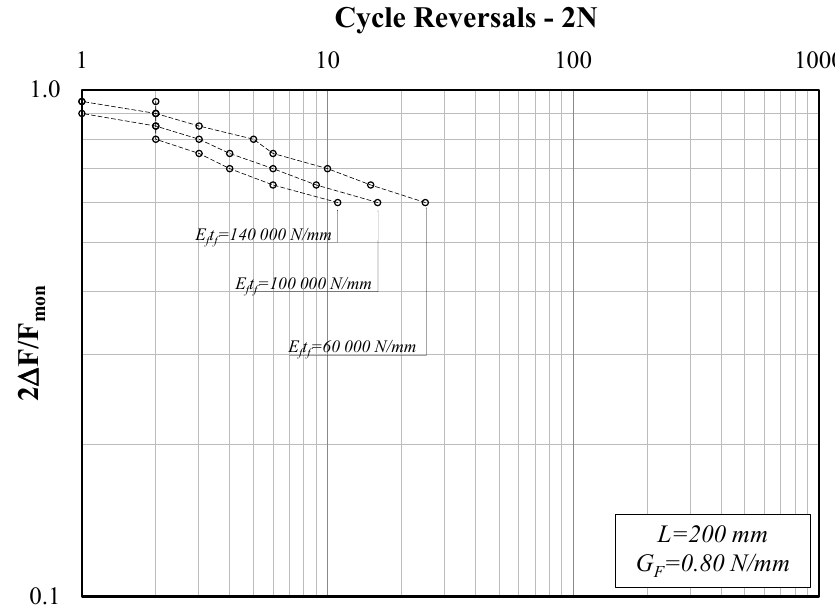
Figure 8. Force amplitude ratio (2 Δ F/F mon ) vs. cycle reversals at debonding (L = 200, G F = 1.00 N/mm).